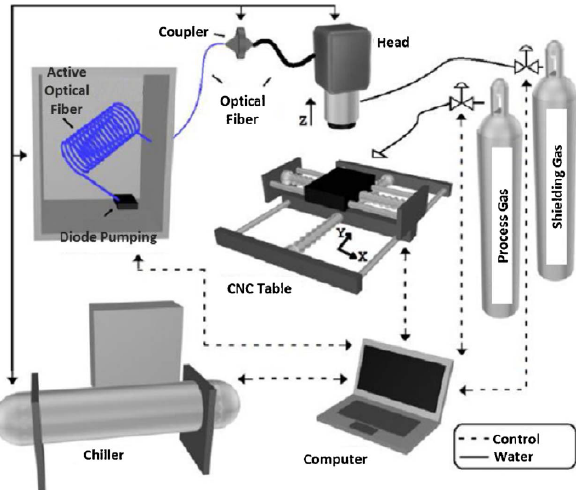
Figure 10: Experimental setup of the Laser welding